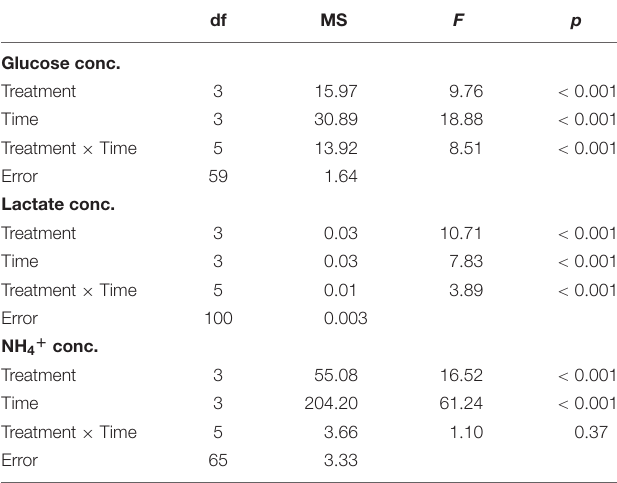
TABLE 4 | The effects of control (C), restricted (R), hypoxic (HR), thermal (TR) treatments on 0 h, 10 min, 2 h and 6 h in ABR-restricted group based on two-way ANOVA. df MS F p Glucose